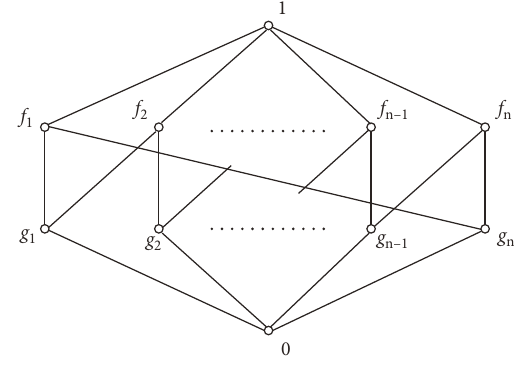
Figure 6: The crown lattice Z